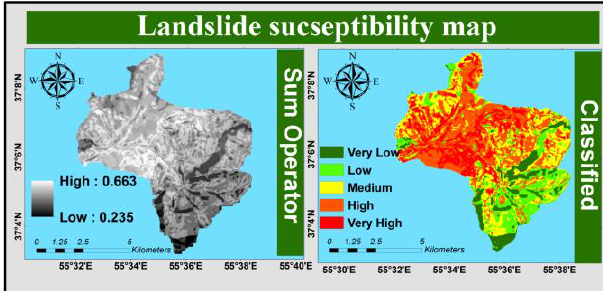
Table 2. Pairwise comparison matrix of scores for calculating weights